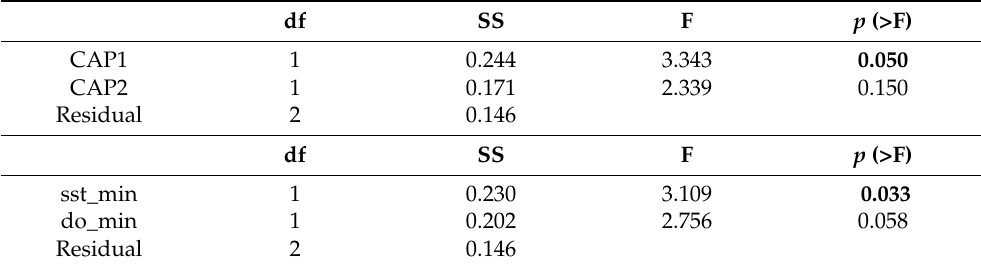
In bold, values significant for p ≤